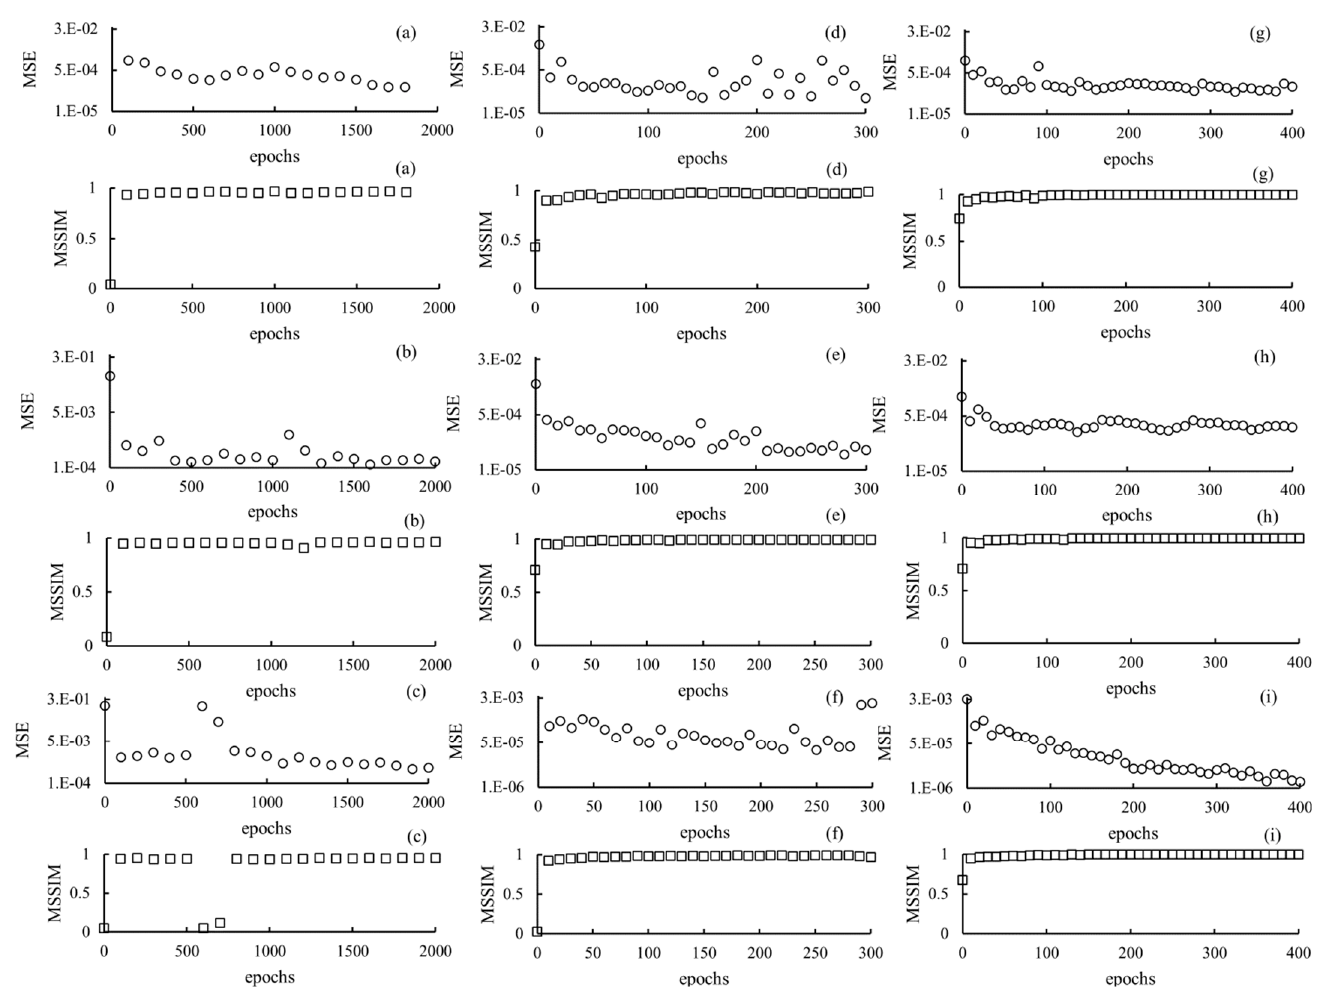
Figure 3. Optimization results for parameter (epochs) determination for each network algorithm at different radiation-dose levels: ( a ) cycle-GAN 0.43 mSv; ( b ) cycle-GAN 0.31 mSv; ( c ) cycle-GAN 0.20 mSv; ( d ) pix2pix2 0.43 mSv; ( e ) pix2pix 0.31 mSv; ( f ) pix2pix 0.20 mSv; ( g ) MPN 0.43 mSv; ( h ) MPN 0.31 mSv; and ( i ) MPN 0.20 mSv.